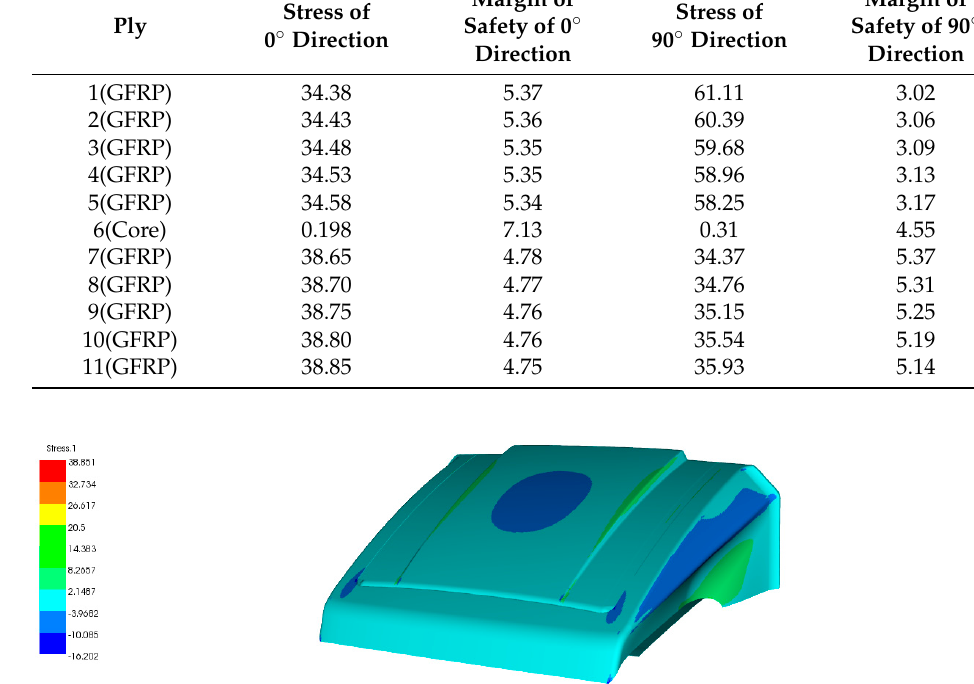
Figure 11. The result of stress analysis about 0 ° direction.